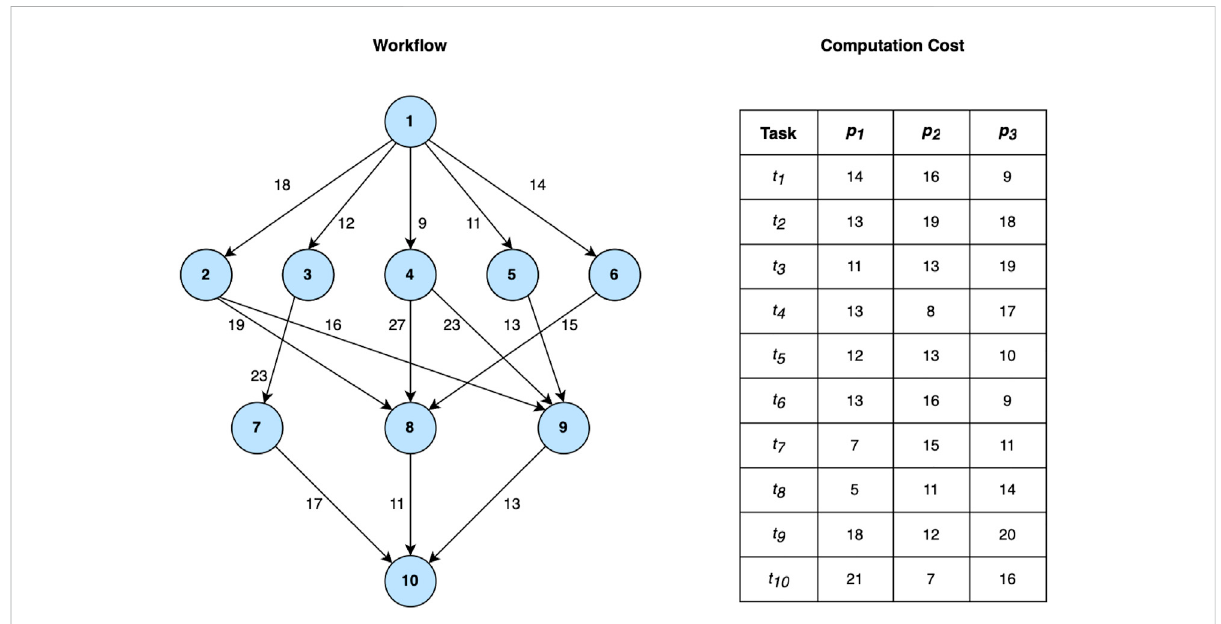
FIGURE 2 A work fl ow with ten tasks and computation cost matrix on three